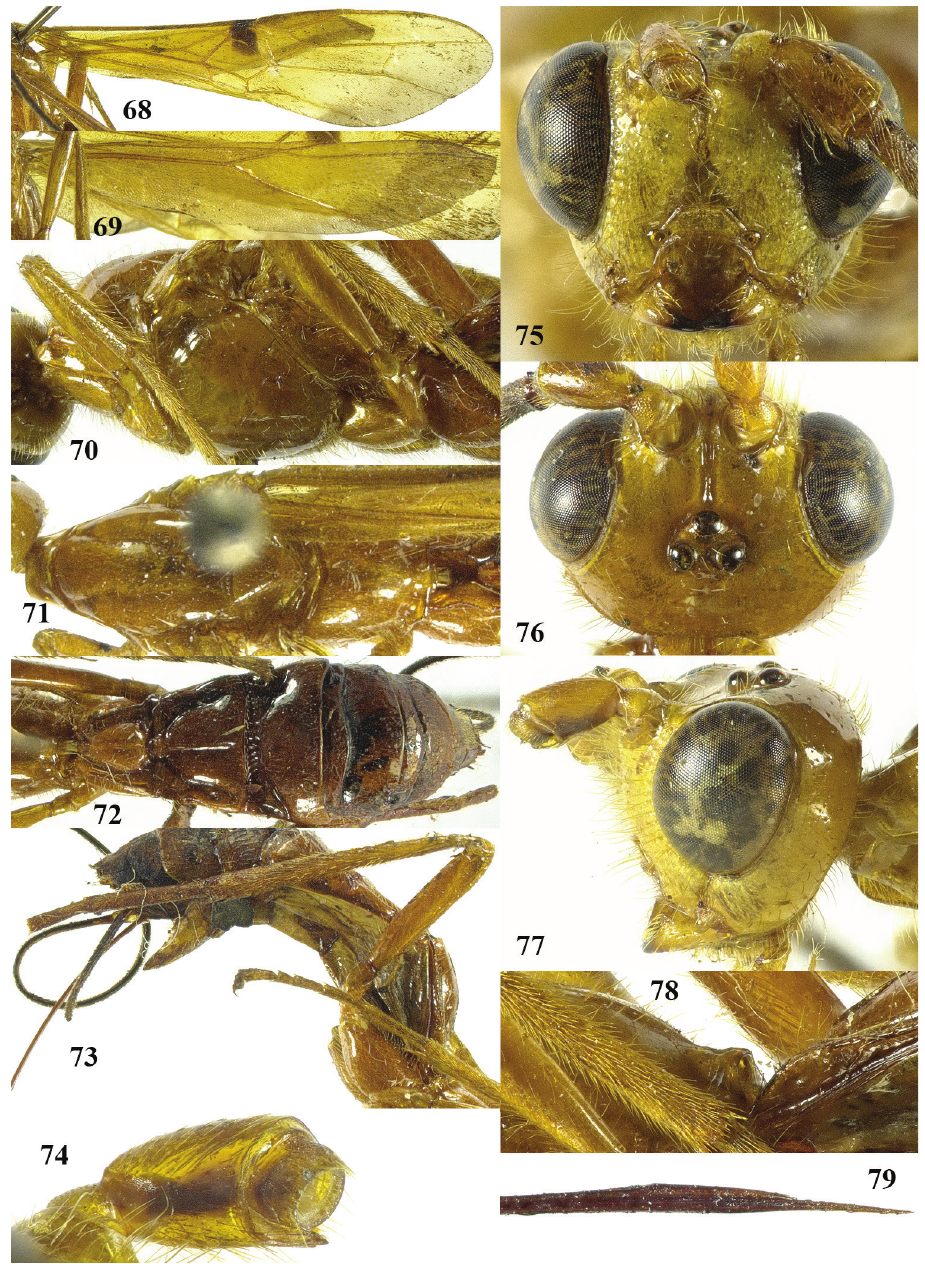
Figures 68–79. Maculibracon luteonervis sp. n., ♀ , holotype. 68 fore wing 69 hind wing 70 mesosoma lateral 71 mesosoma dorsal 72 metasoma dorsal 73 hind leg lateral 74 scapus outer side lateral 75 head anterior 76 head dorsal 77 head lateral 78 propodeum lateral 79 apex of ovipositor